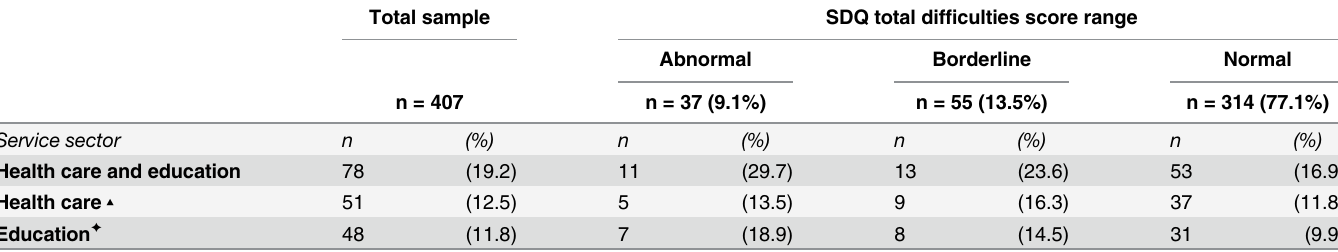
Table 2. Past-year service use by sectors for the total sample and by Strengths and Difficulties Questionnaire (SDQ) score